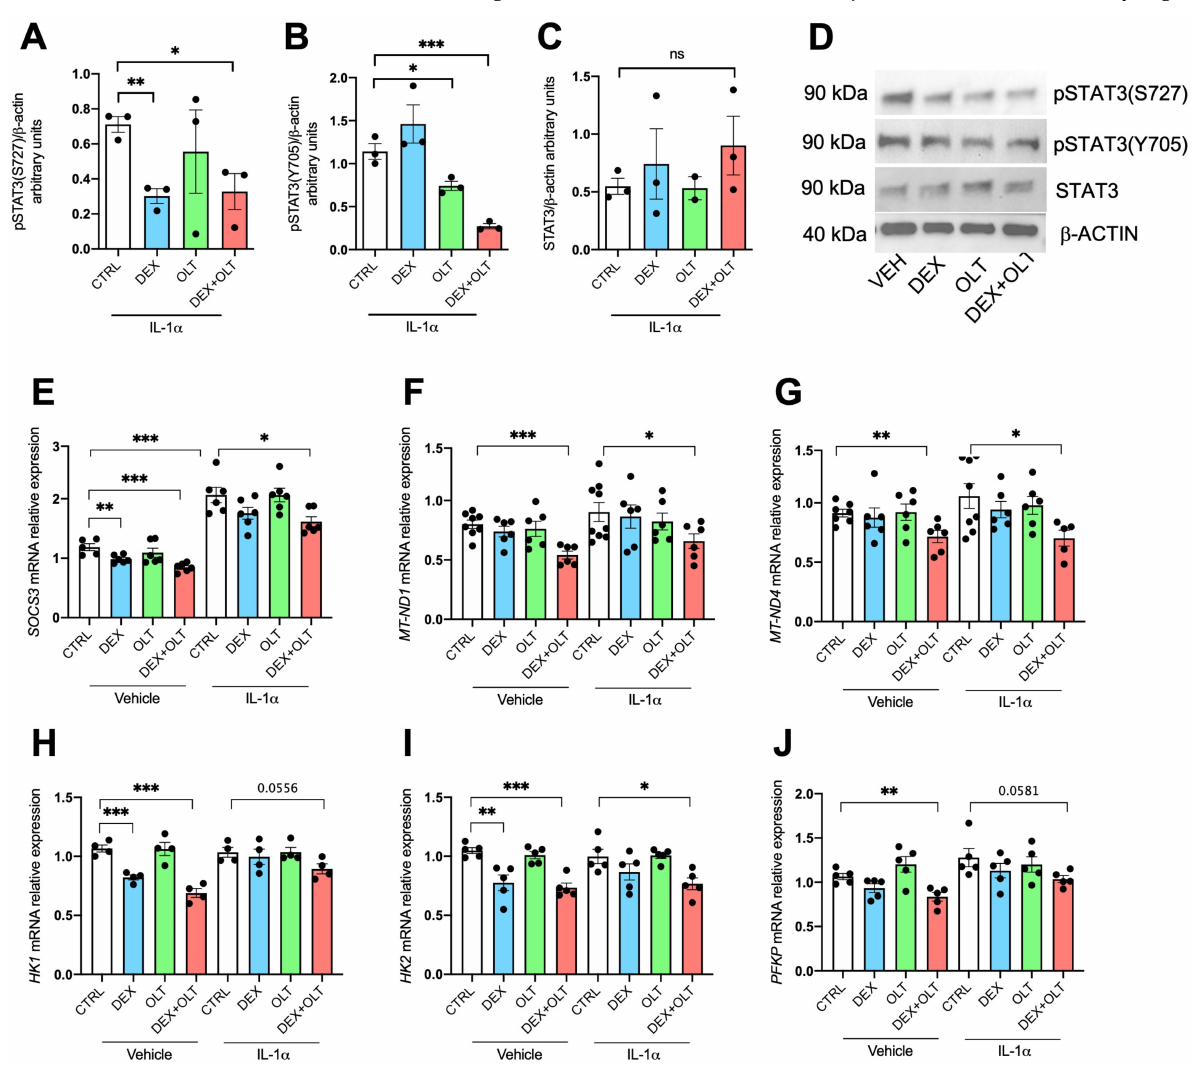
Figure 4. STAT3 phosphorylations and activities are inhibited by OLT1177 and dexamethasone in LU1205 cells. ( A ) Western blot of pSTAT3 (S727) levels in 1205Lu cells treated with IL-1 α fol- lowed by vehicle, dexamethasone, OLT1177 or the combination of dexamethasone plus OLT1177. ( B ) A representative Western blot of pSTAT3 (Y705) levels in the same cells as in A. ( C ) A represen- tative Western blot of total STAT3 levels cells shown in A. ( D ) Representative pictures of LU1205 lysates. The data are shown as mean ± SEM. ( E – I ) Gene expression of ( E ) SOCS3 , ( F ) MT_ND1 , ( G ) MT_ND4 , ( H ) HK1 , ( I ) HK2 , and ( J ) PFKP , respectively, in cells stimulated with IL-1 α or vehicle and then treated with IL-1 α , dexamethasone, OLT1177 or dexamethasone plus OLT1177. The data are presented as mean ± SEM. * p < 0.05; ** p < 0.01; *** p <